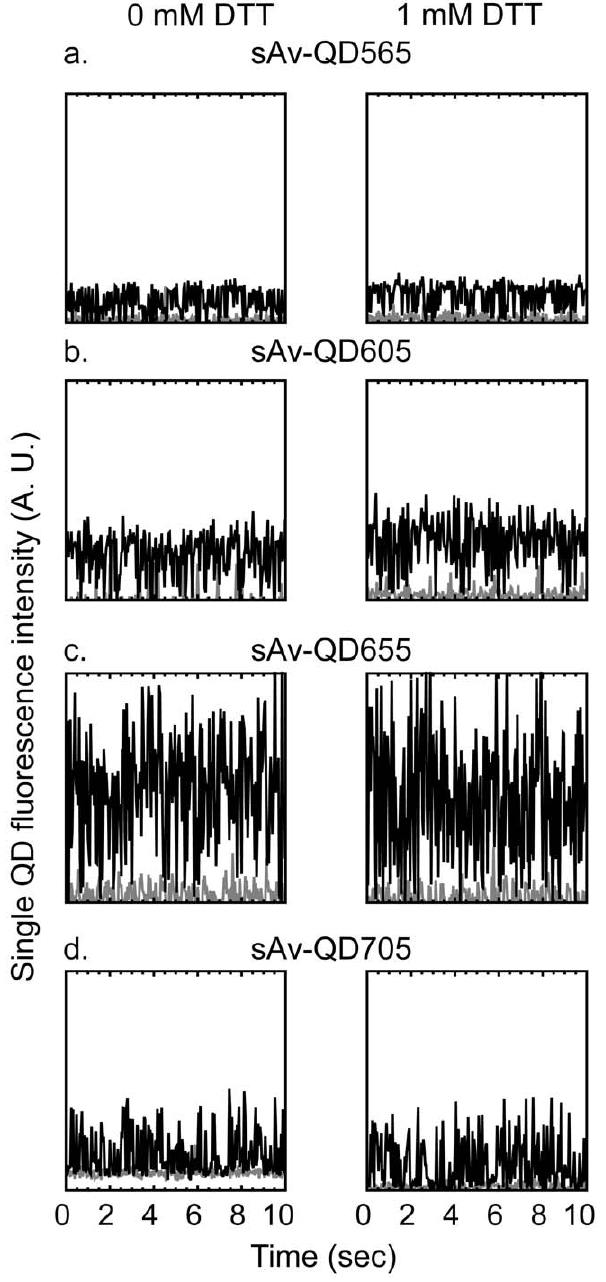
Figure 4. Representative, background subtracted, integrated fluorescence intensities, as a function of time, of identified single sAv-QD565, sAv-QD605, sAv-QD655, and sAv-QD705 (black lines) that had been absorbed non-specifically to a glass coverslip in the absence of DTT (left) and in the presence of 1 mM DTT (right). Images of QDs with different peak emissions were acquired under identical conditions with continuous blue illumination with 5 ms camera integration at an image acquisition rate of < 25 Hz for 300 image frames. Also shown are the fluorescence intensity fluctuations of the background (grey lines). The results for sAv-QD525, sAv-QD585, sAv-QD625, and AMP-QD800 are given in Fig. S3.